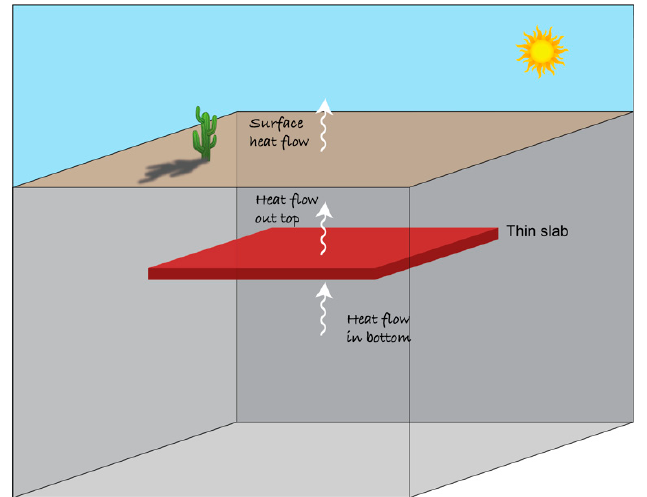
Figure 1. Schematic view of one-dimensional thermal model of a magma sheet with thickness much less than horizontal dimensions. Whether or not the magma body grows depends on the balance between heat in the bottom (as magma) and heat out the top. As heat eventually escapes to the surface, over the long term heat out the top of the sheet averages out to surface heat flow.